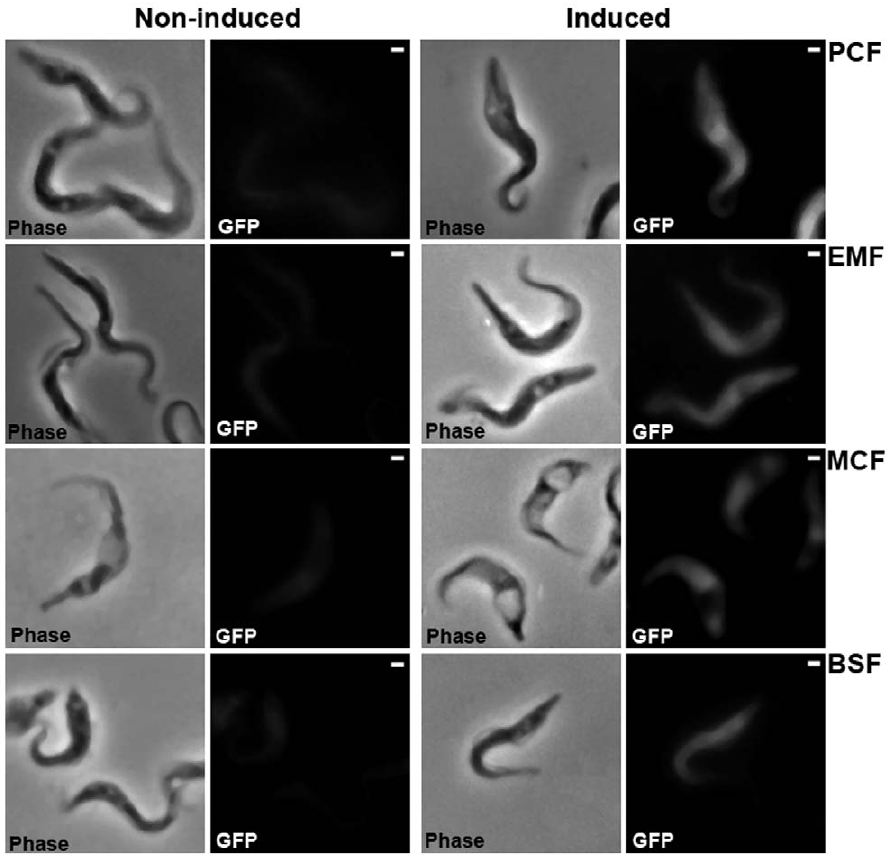
Figure 1. Inducible expression of EGFP through the T.congolense life cycle. Microscope images of the in vitro cultivated IL3000:13–29 strain transfected with pLEW20c-EGFP vector in all the developmental stages. Non induced and tetracycline (1 m g/ml for 48 h) induced cells were fixed and visualized in phase contrast and by EGFP fluorescence (images were recorded with the same exposure time). Scale bars=1 m m.